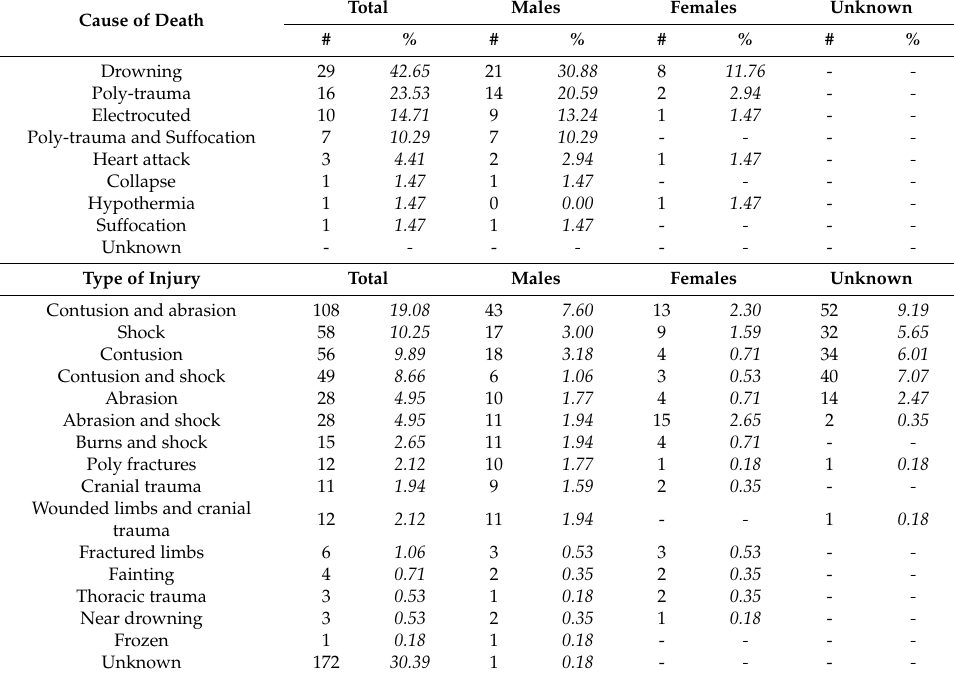
Table A3. Gender, causes of death and type of injured.